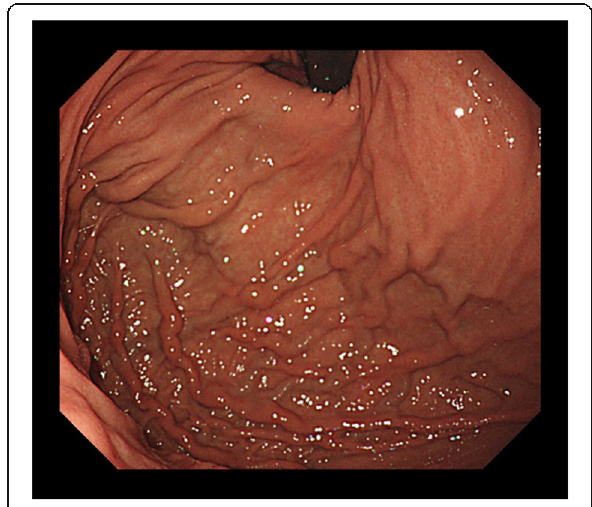
Fig. 3 Upper gastrointestinal endoscopy at 3-months postoperatively showed disappearance of the gastric